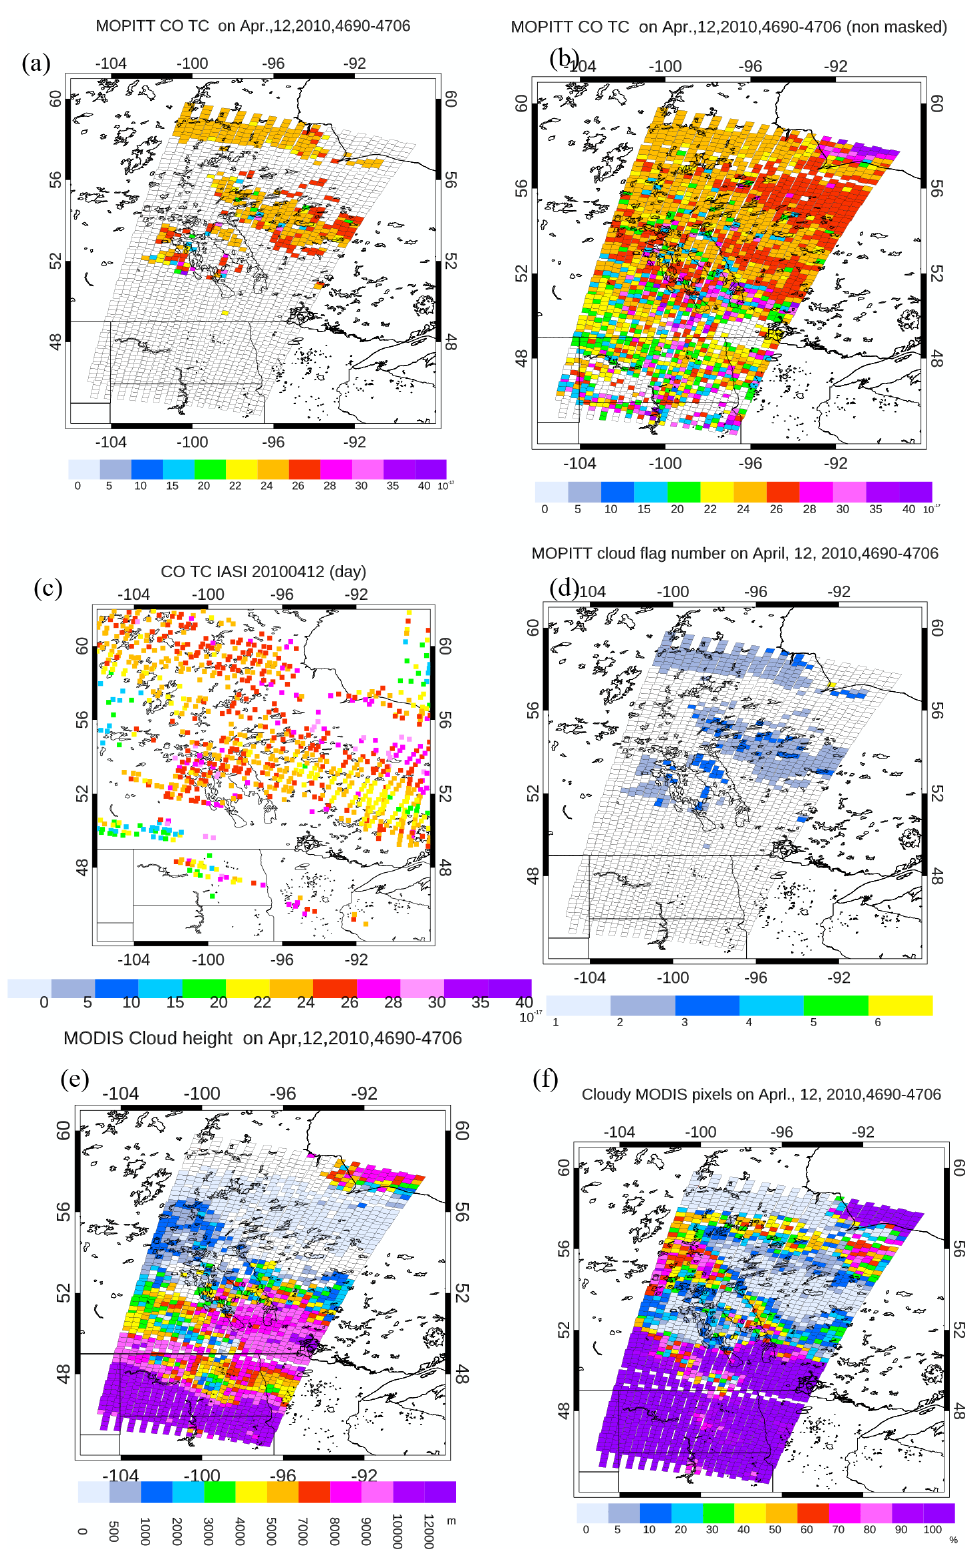
Figure 7. The same as Fig. 3 but for 12 April